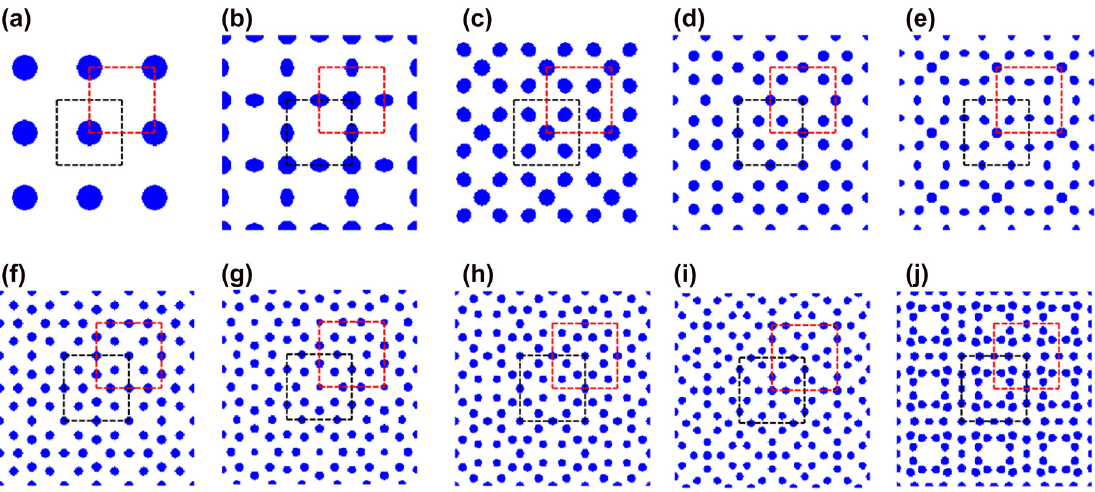
Figure1: OptimizedPCshostingdifferentodd-orderbandgaps:(a)the fi rst-order;(b)thethird-order;(c)the fi fth-order;(d)theseventh-order; (e) the ninth-order; (f) the eleventh-order; (g) the thirteenth-order; (h) the fi fteenth-order; (i) the seventeenth-order; (j) the nineteenth-order. The black dashed box denotes the UC n A and the red dashed box denotes the UC n